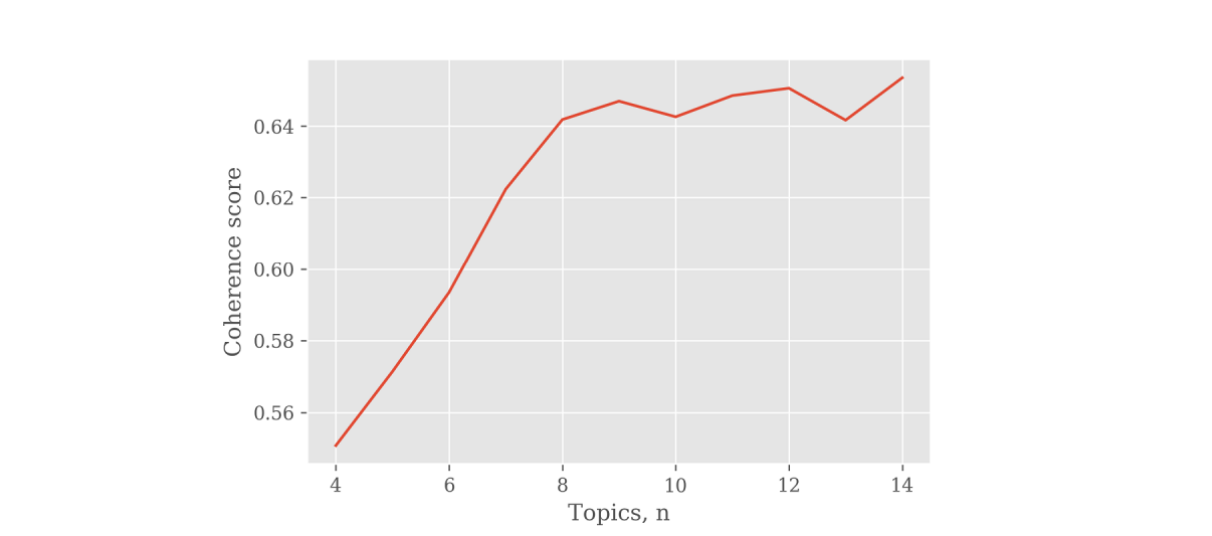
Figure 2. Coherence score by the number of